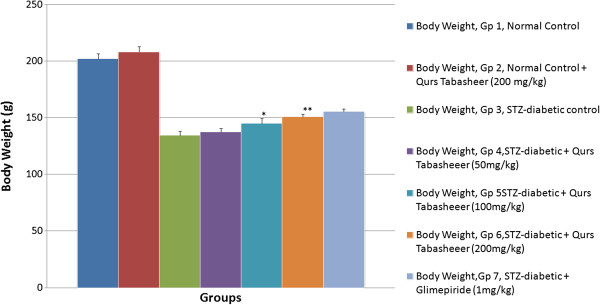
Effect of Qurs Tabasheer on body weight at different concentrations on normal and STZ induced diabetic rats, compared to standard drug Glimepiride; values are mean ± SEM; n = 6; *P < 0.05; **P < 0.01; ***P < 0.001; P > 0.05 is considered as non-significant (ns).